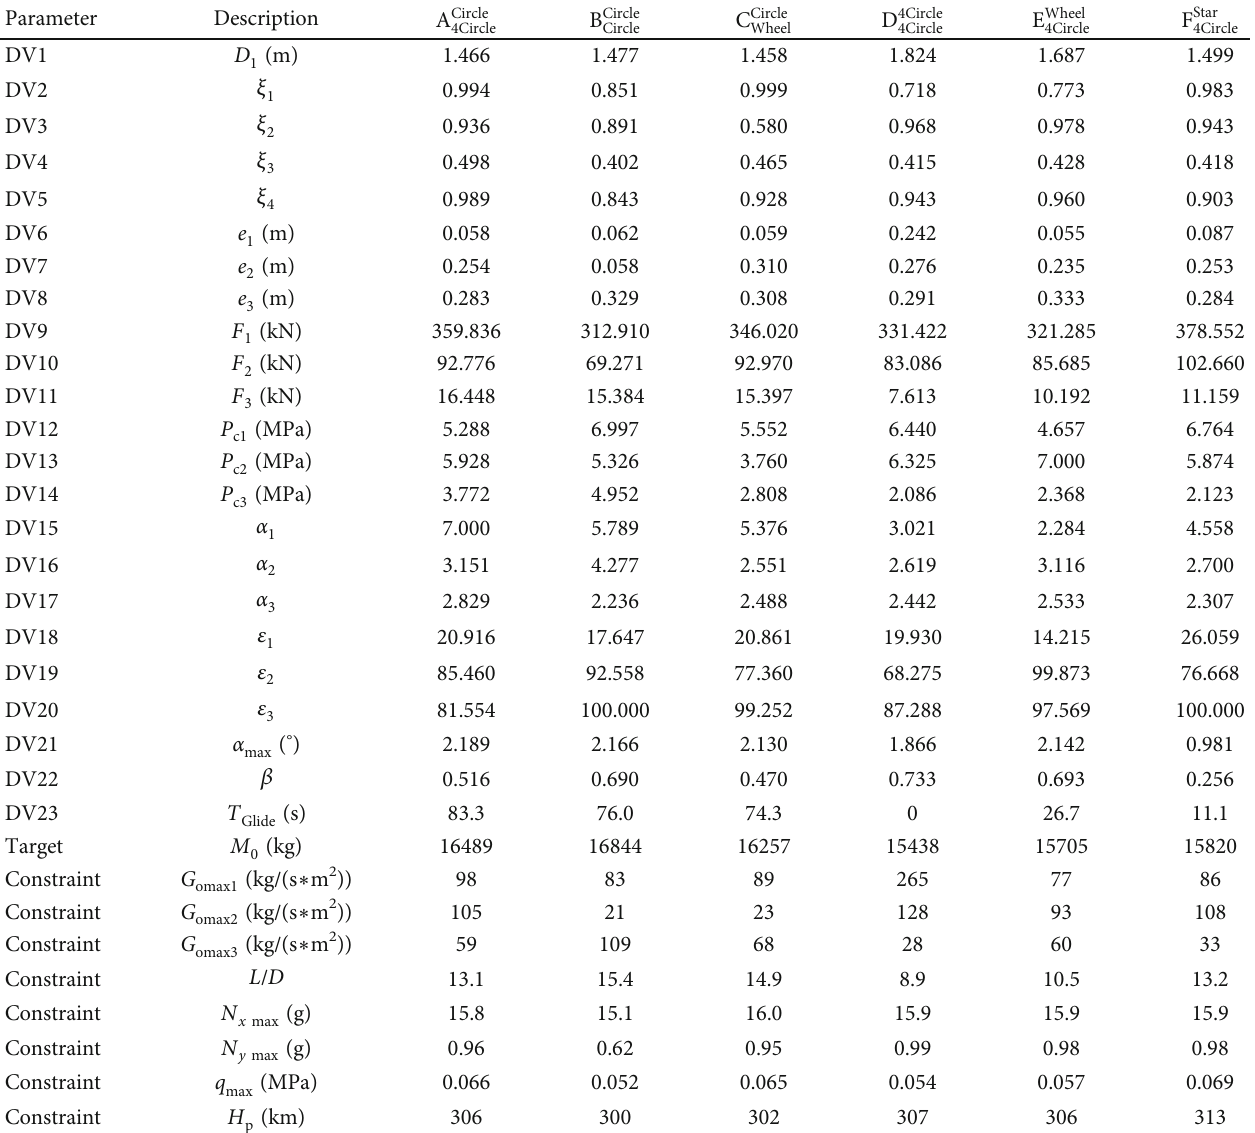
Table 6: Optimal results of SLV cases with di ff erent grain